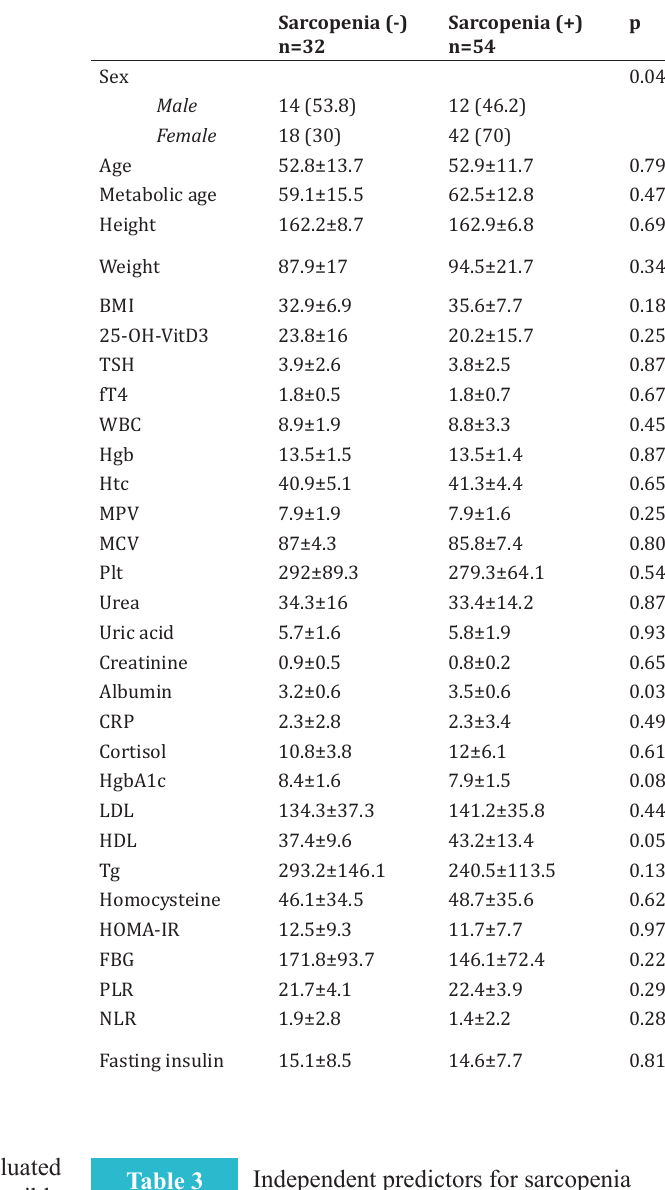
Comparison of general characteristics of patients between sexes Table